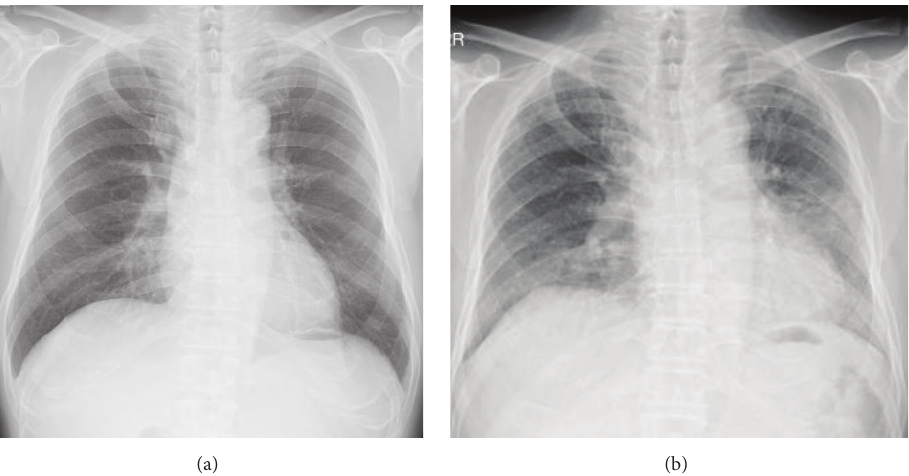
Figure 1: Chest X-ray images at the time of diagnosis with BD (a) and at the first time appearance of dyspnea (b).